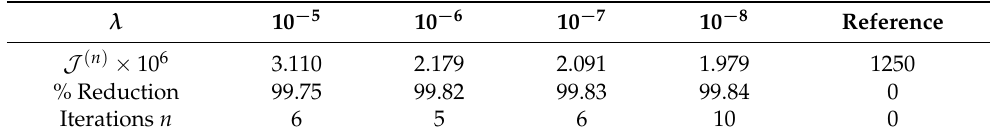
Table 2. Temperature matching case with Dirichlet boundary control: objective functional, percentage reduction, and number of iterations of the optimization algorithm for different λ